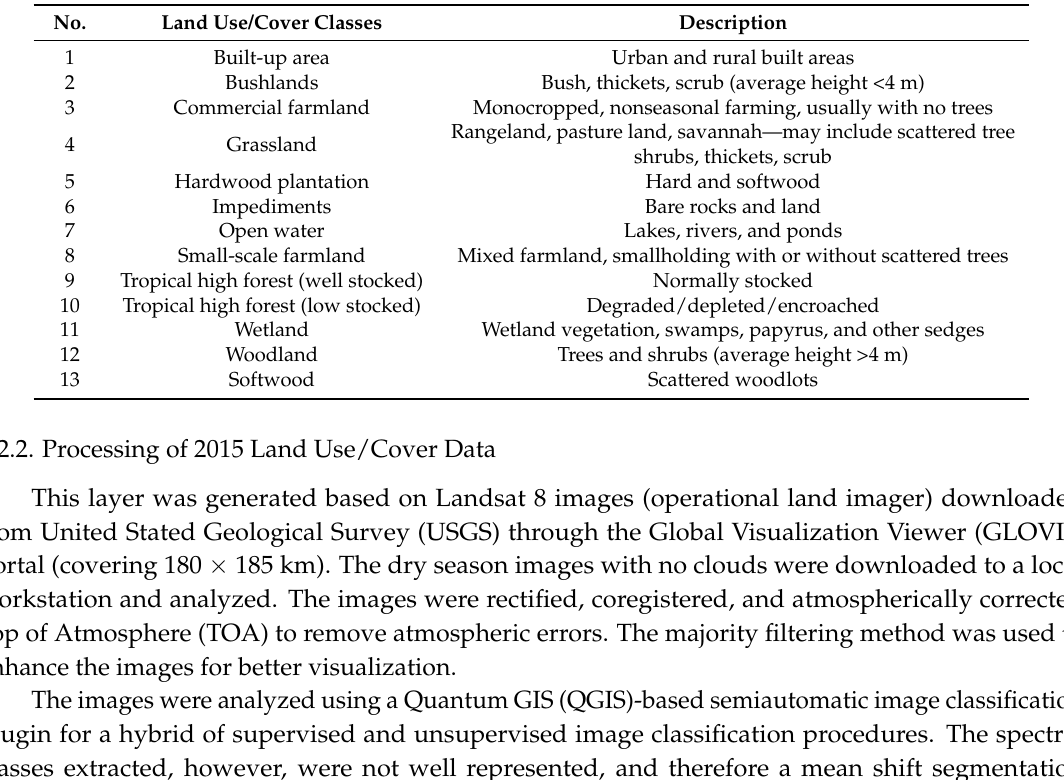
Table 1. Description of the National Biomass Study’s land use/cover classes (1990).